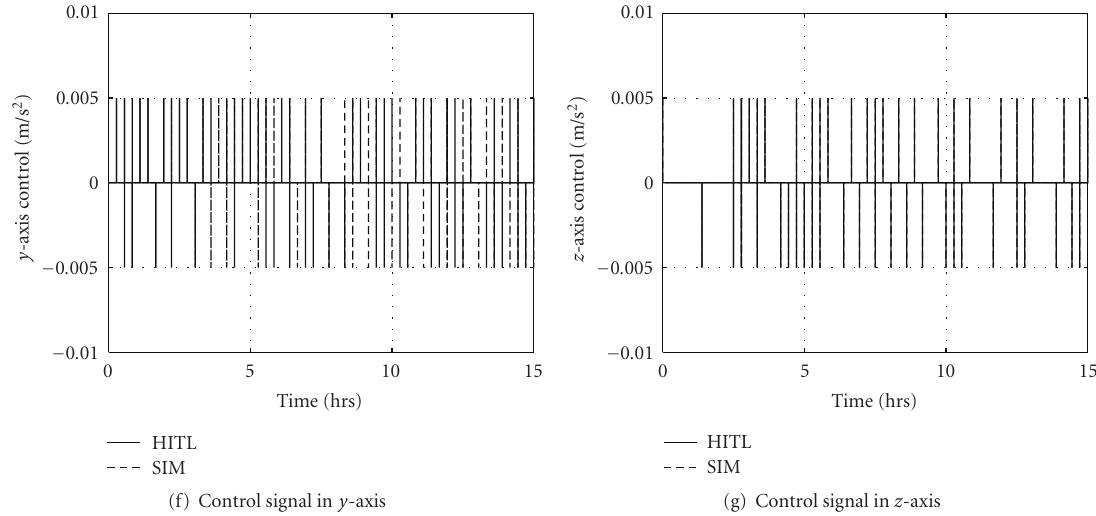
Figure 12: HITL simulation results with Fuzzy Logic control (control interval: 1000 seconds; maximum firing time: 2